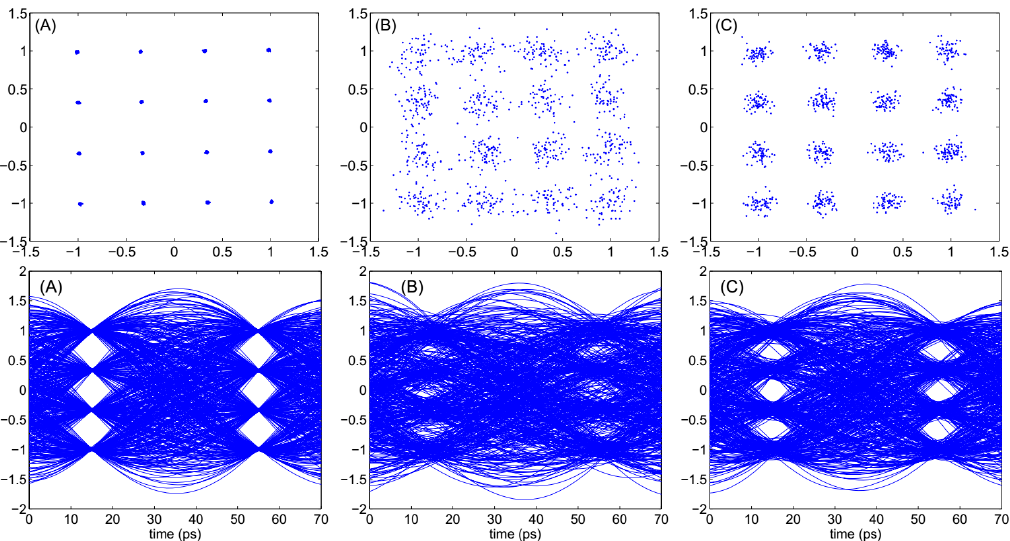
Figure 8. Constellation and eye diagrams. ( A ) B2B; ( B ) After chromatic dispersion (CD) compensation; ( C ) After cross-phase modulation (XPM) compensation.